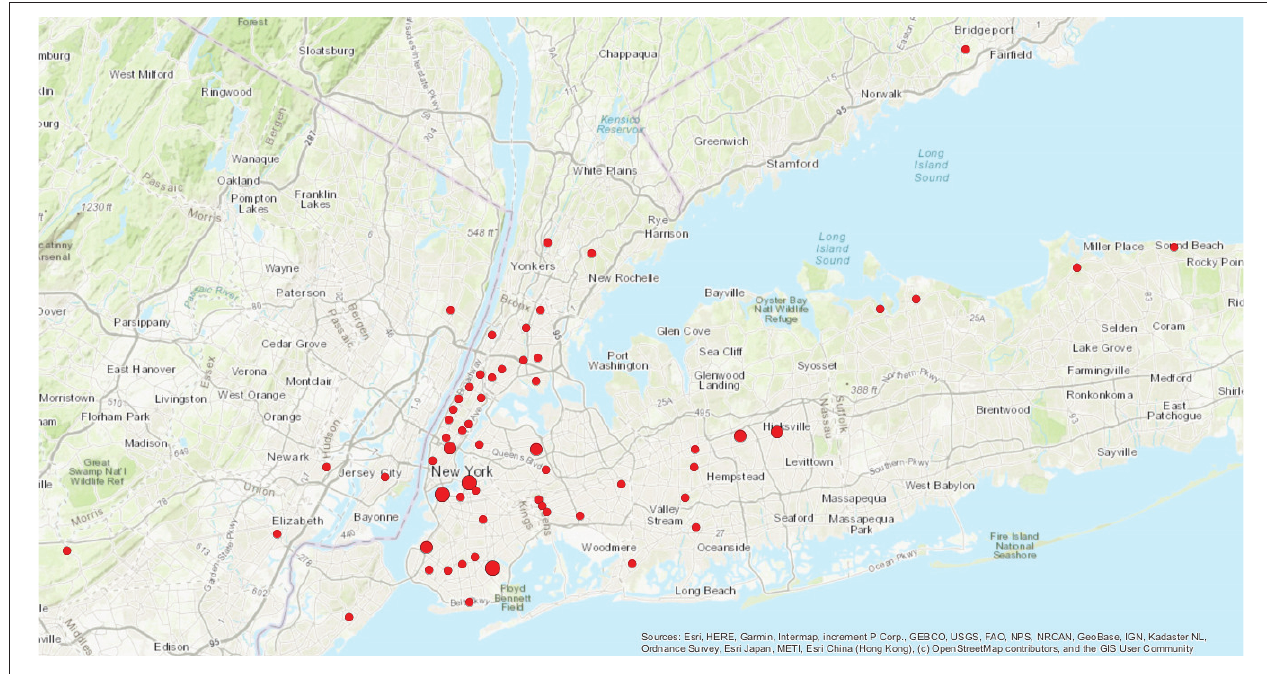
FIGURE 1 | Distribution of patients by zip code. One patient per zip code. Two patients per zip code. Three patients per zip